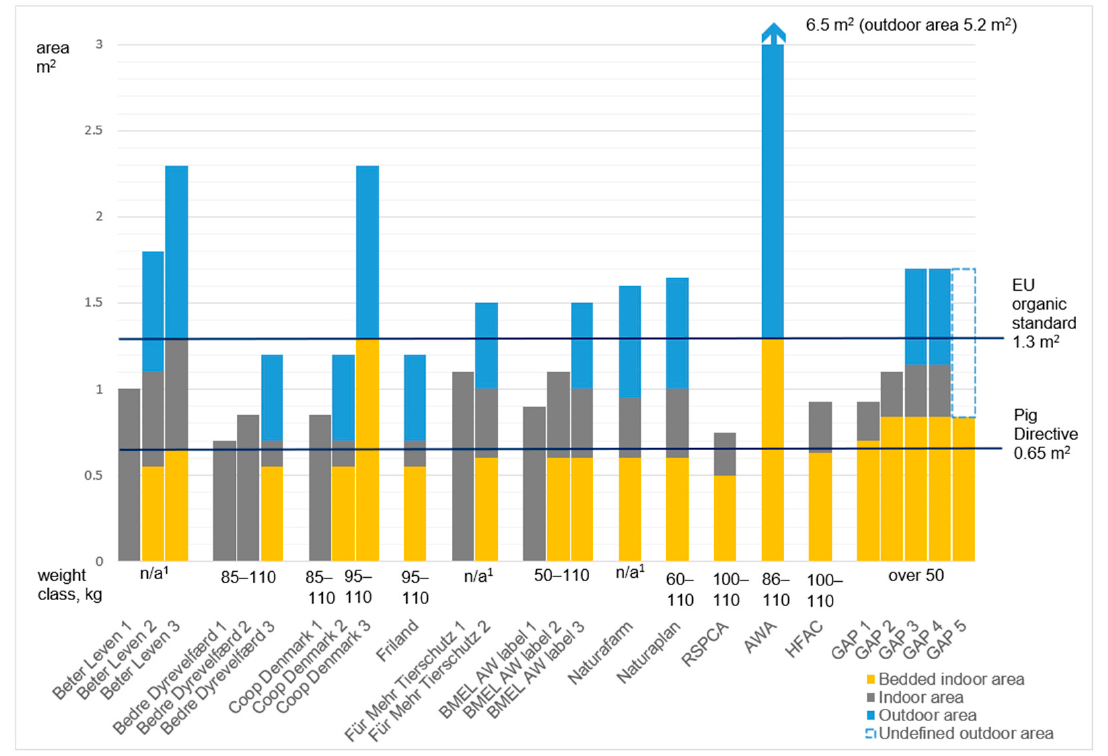
Figure 1. Minimum total area, lying area, and outdoor access requirement in the reviewed schemes. 1 n/a = not applicable.